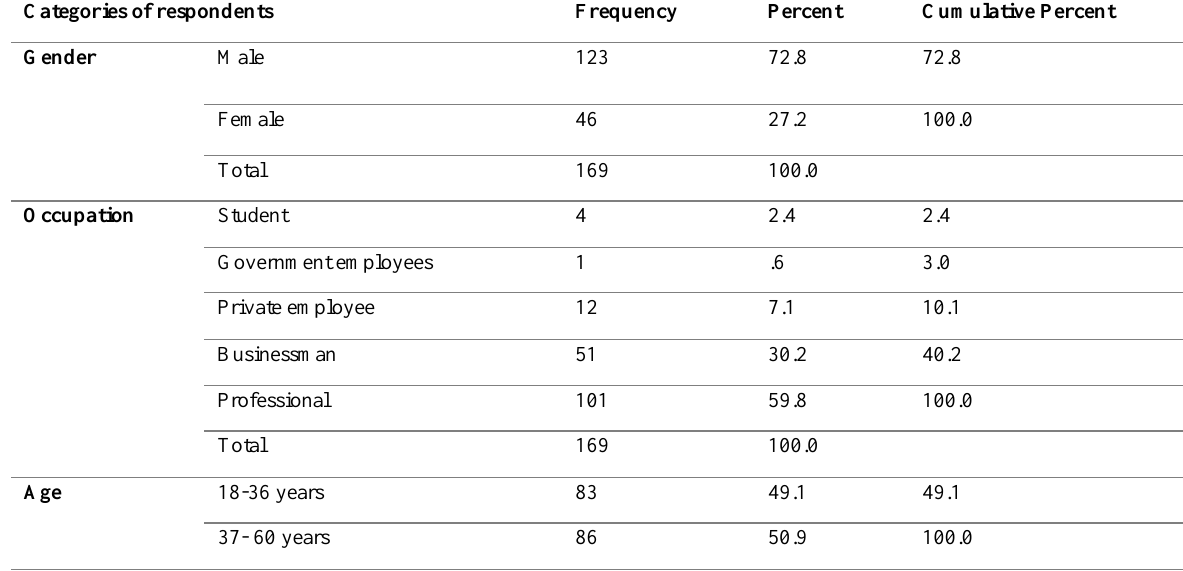
Table 2: Demographic